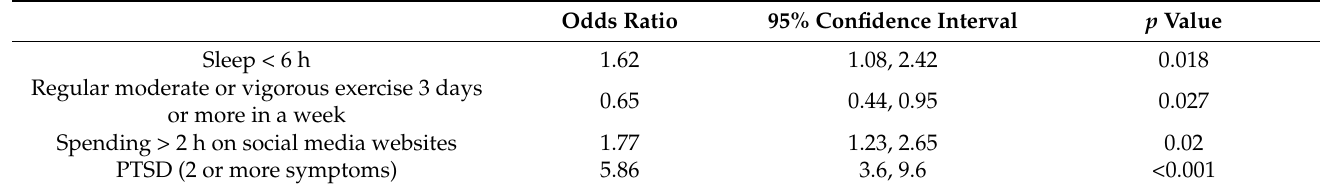
Table 4. Lifestyles and health status were found to be significantly associated with emotional status, feeling sad and hopeless, and seeking help from others, using multivariate